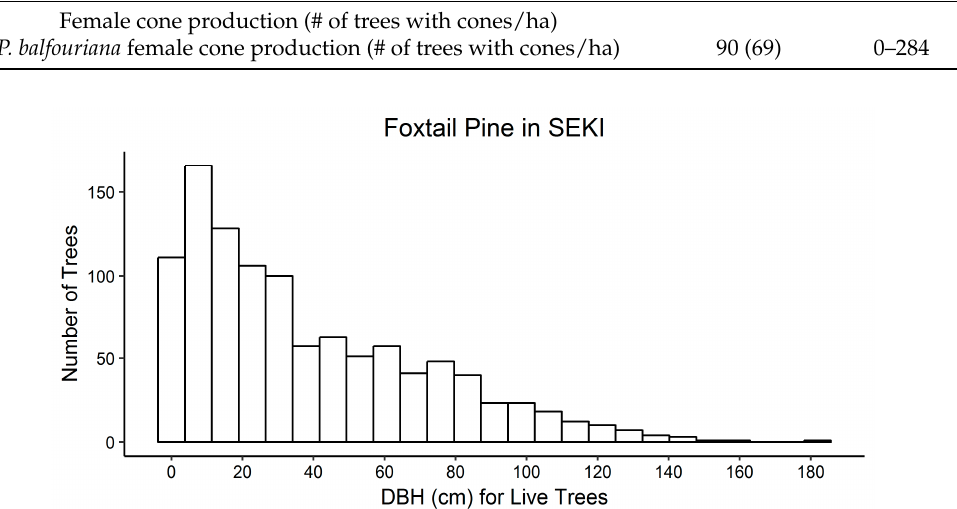
Figure 10. Histogram of all live foxtail pine diameter at 1.37 m (DBH) in Sequoia and Kings Canyon National Parks (SEKI), CA, USA. DBH ranged from 0.4 to 182.3 cm.